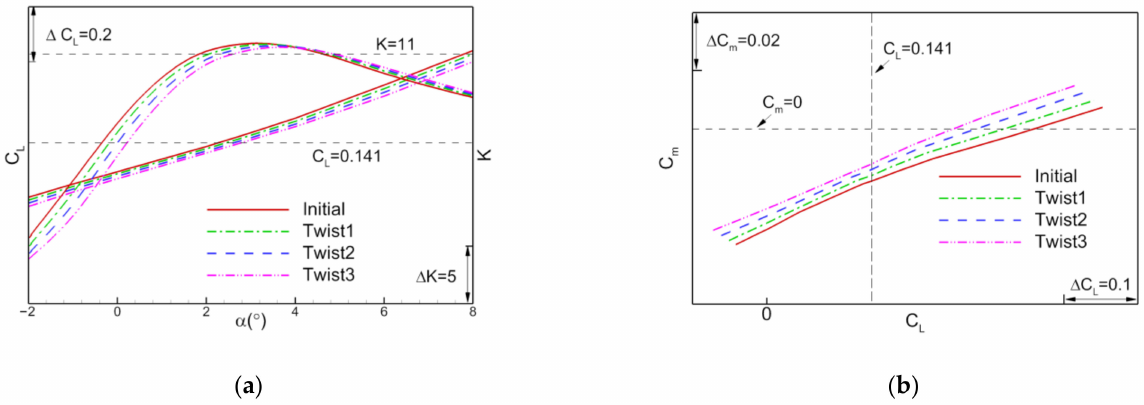
Figure 13. Aerodynamic characteristic of the configurations with different twist angles. Ma = 0.85, H = 11 km, α = − 2 ◦ ∼ 8 ◦ , ∆ α = 2 ◦ . ( a ) Lift coefficient, lift to drag ratio; ( b ) Pitching